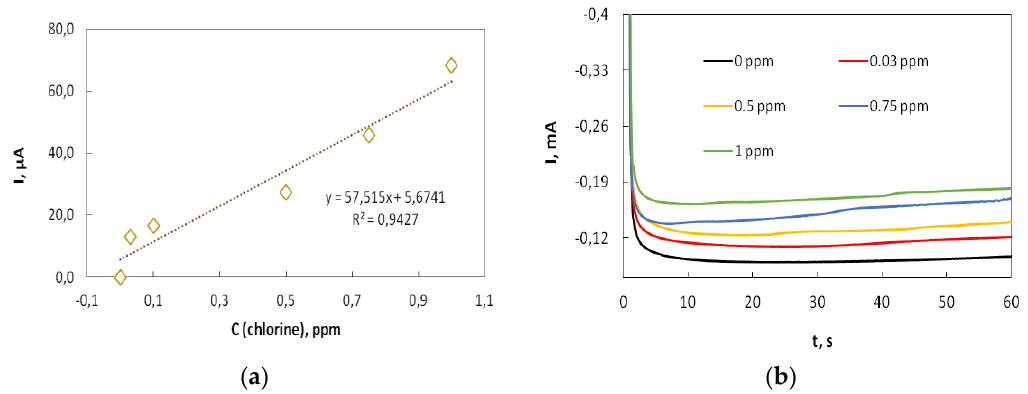
Figure 10. Calibration curve for sensors ( a ) and typical chronoamperometric curves for free chlorine detection in acetic acid buffer ( b ).